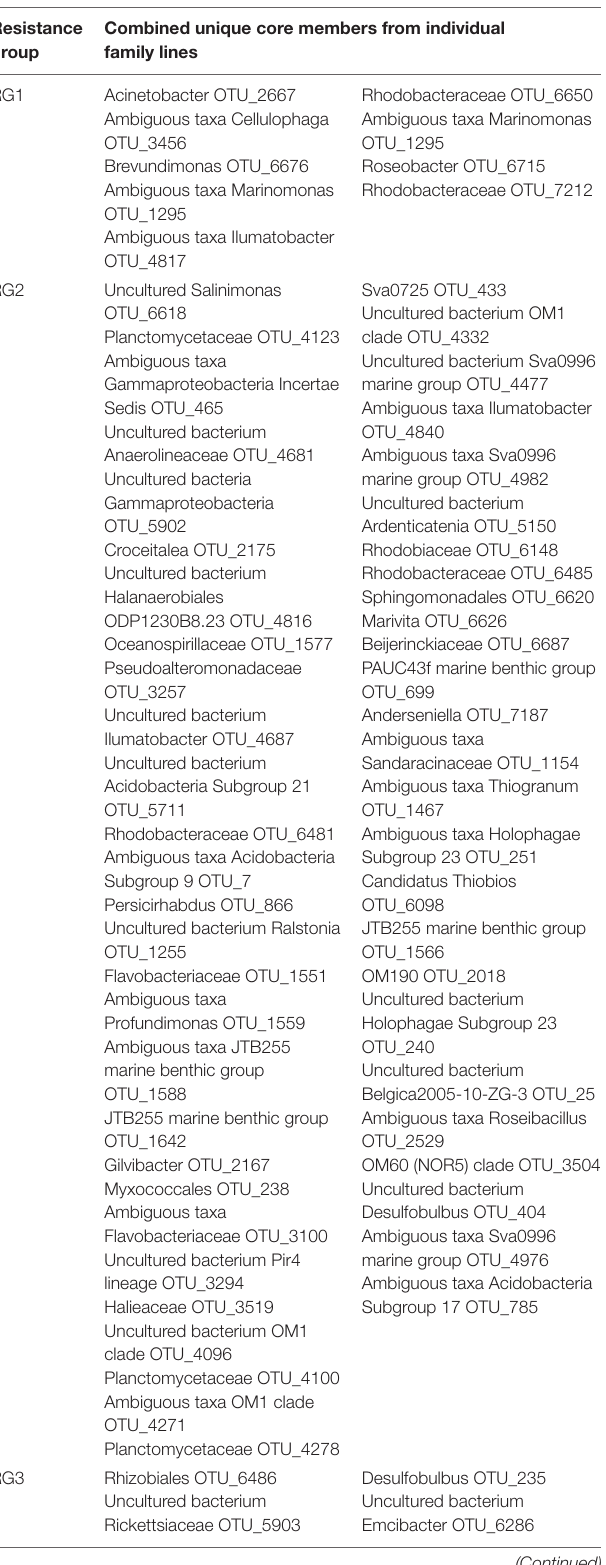
TABLE 2 | Unique core bacterial members from individual oyster families collated into their respective resistance groups (RG). Resistance Combined unique core members from individual group family